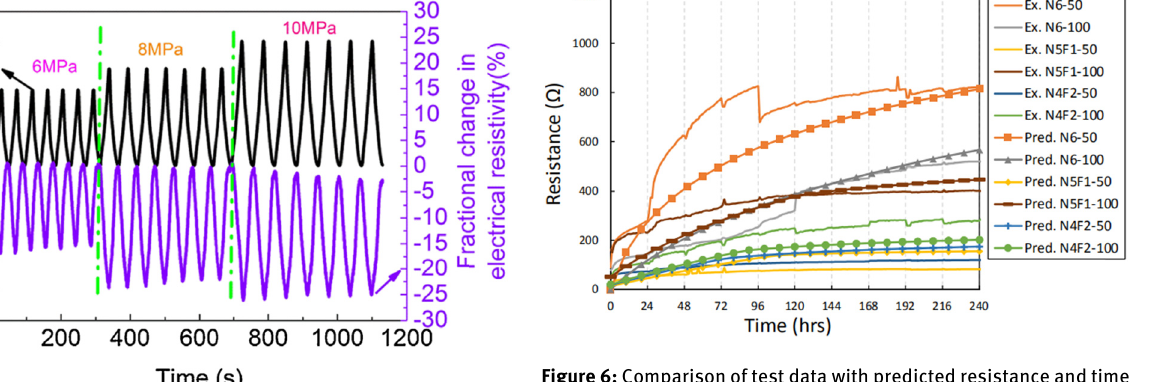
Figure 6: Comparison of test data with predicted resistance and time responses of CNTCS [ 54 ] ( Ex. – test value; Pred. – predicted value; N5F1 - 50 = 5 g CNT + 1 g CF + 50 g fi ne aggregate, the rests are similar )